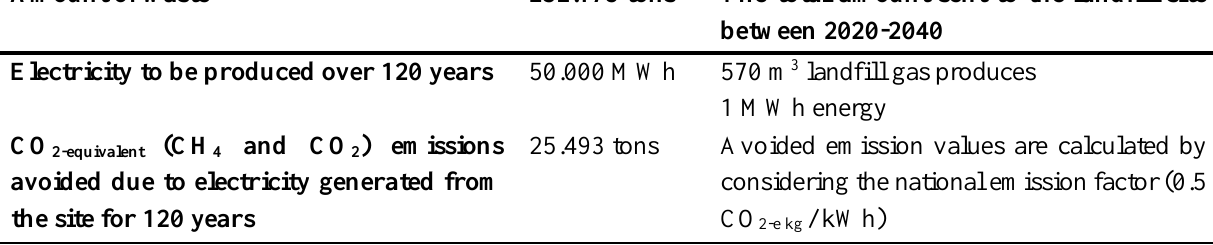
Table 1. Electricity generation potential in the Edirne Solid Waste Landfill Facility over 120 years Amount of